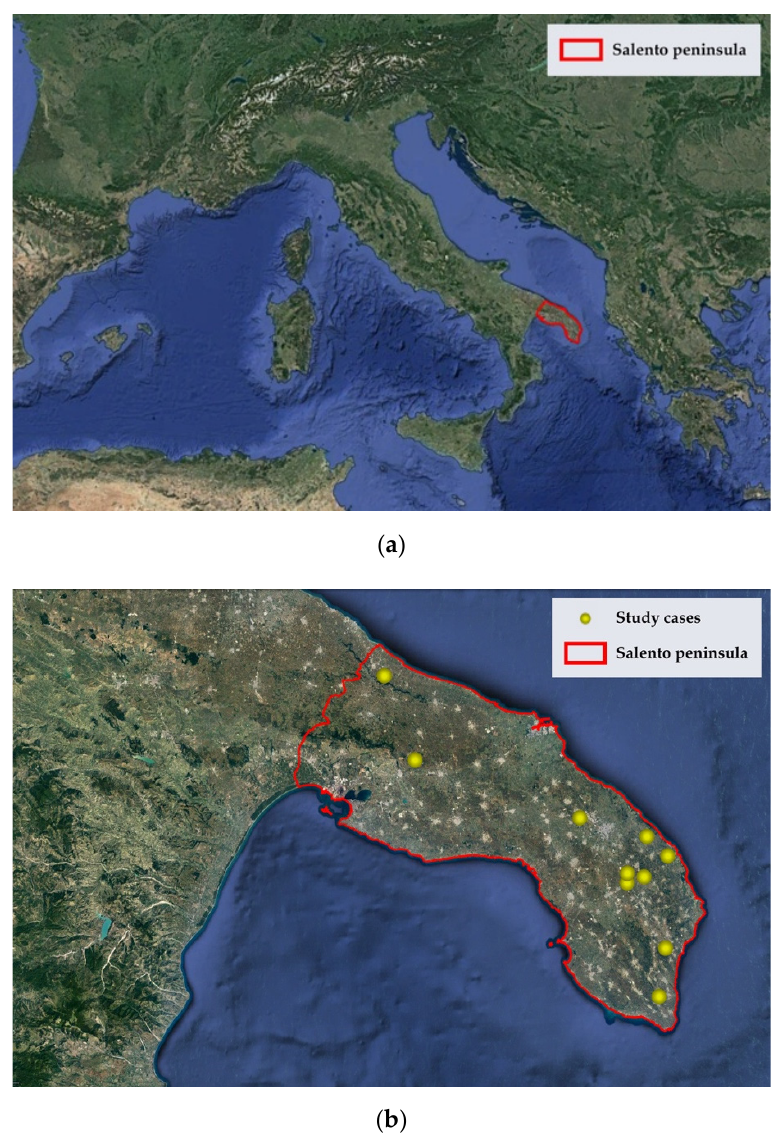
Figure 3. Study area: ( a ) Salento peninsula in the Puglia region, Italy; ( b ) 10 case studies identified.